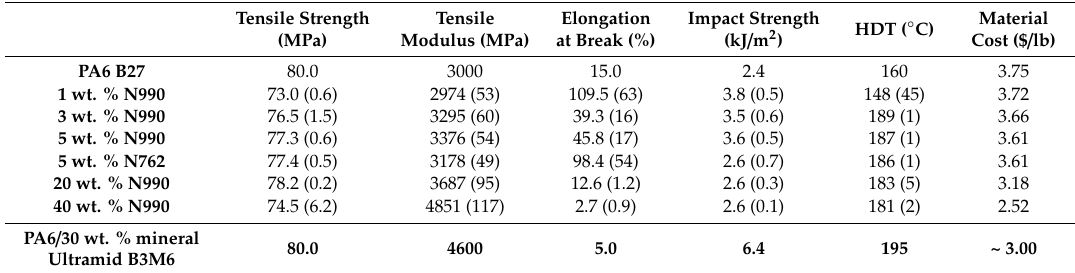
Table 3. Properties (and SD) of PA6 / TB N990 composites.